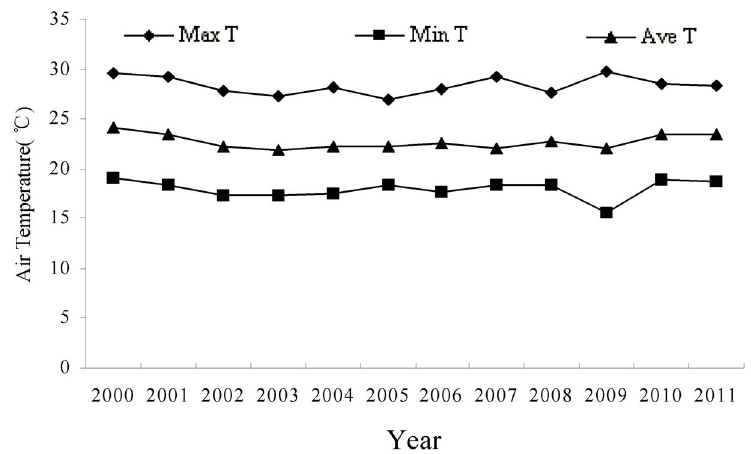
Figure 1. The average maximum, minimum and mean air temperatures on the semi-arid Songnen Grassland during summers (Jun- Aug) from 2000 to 2011. Data were collected by the Meteorological Bureau of Changling County, China.